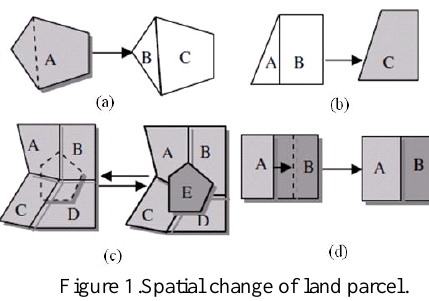
Figure 1.Spatial change of land